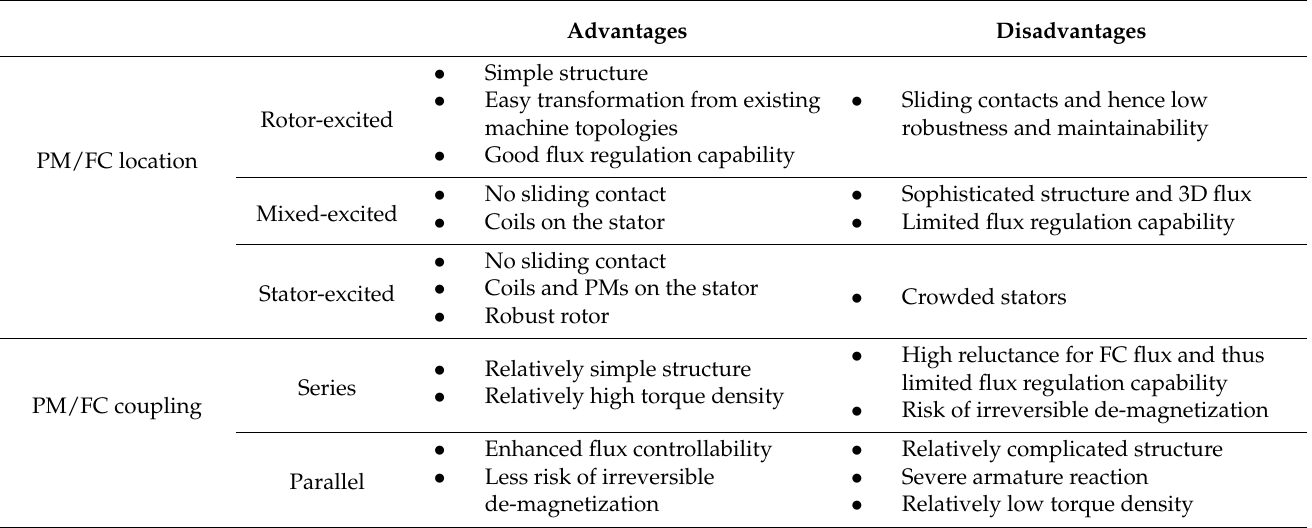
Table 1. Advantages and disadvantages of various HE